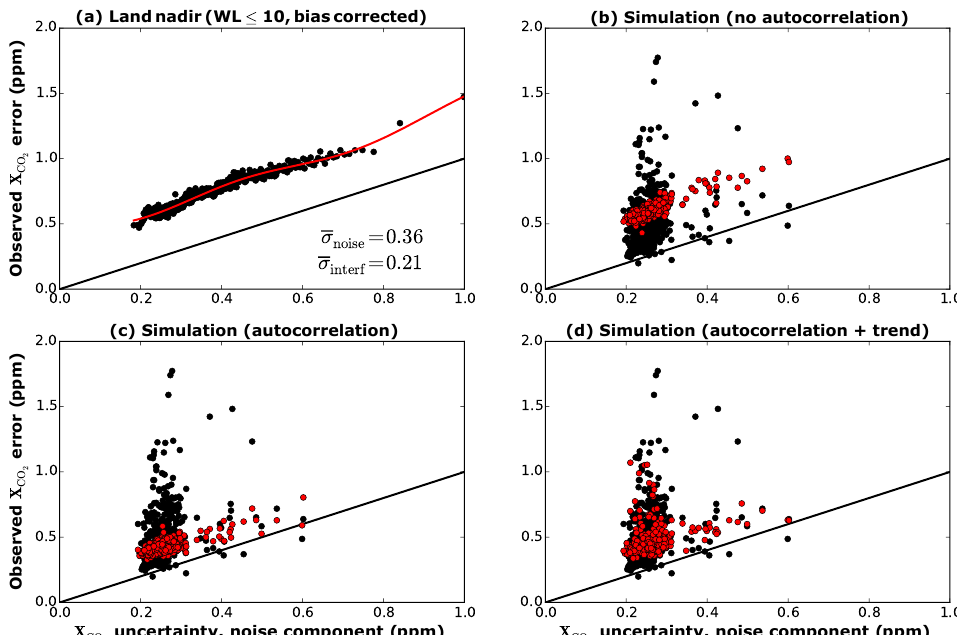
Figure 1. The calculated, observed, and modeled uncertainties for land-nadir observations. The black circles are the observed distributions and red circles are modeled distributions. (a) Comparison between expected and actual error when binning all the data by their calculated uncertainty; the solid black line is the one-to-one line. (b) Comparison between calculated and random error for each neighborhood (black) versus model (red) when using observed random error from Fig. 1a. (c) Same as Fig. 1b but now adding a correlation between adjacent data points. (d) Same as Fig. 1b but now accounting for distribution of observed gradients across the neighborhoods used for analysis.